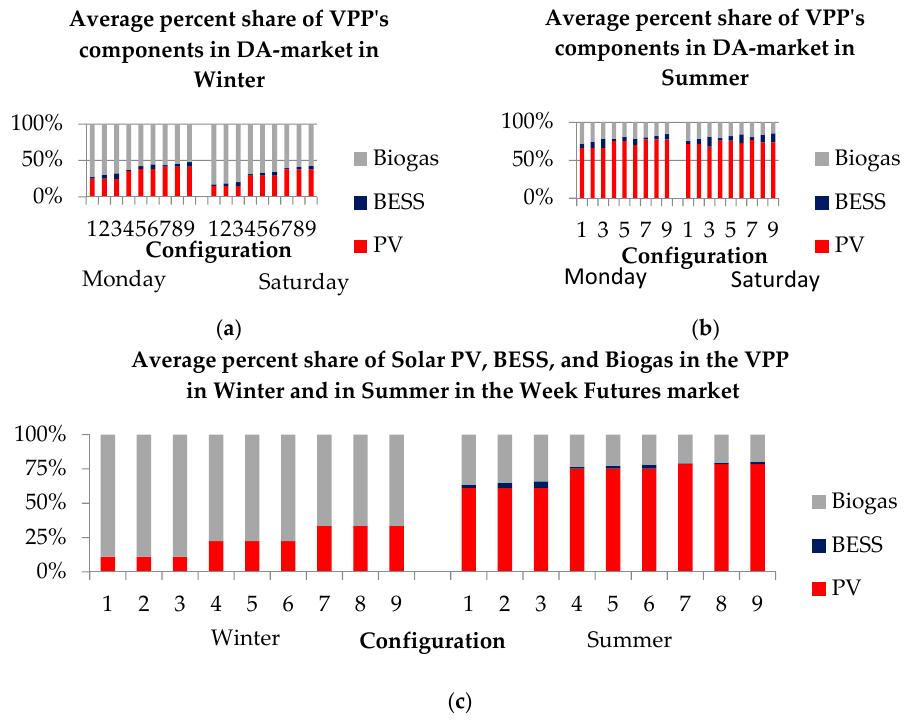
Figure 11. The share of PV, BESS, and biogas in the VPP for the different market products: ( a ) averages on Monday and Saturday in winter in the Day-Ahead (DA) market; ( b ) averages on Monday and Saturday in summer in the DA market; ( c ) in summer and winter in the Week Futures market.